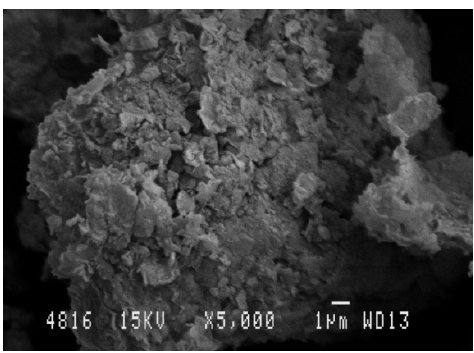
Figure 2. Montmorillonite (MMT) SEM.